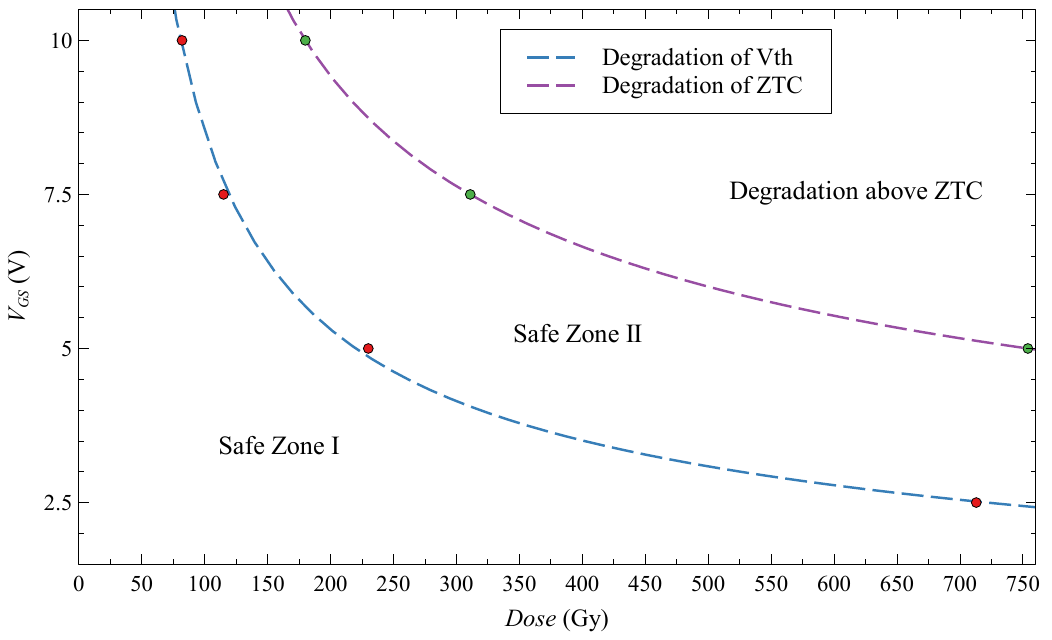
Figure 13. Safe Operating Area of EPAD. Red dots are representing the measured values for V th ( I D = 1 µ A) and green dots for ZTC ( I D = 68 µ A)